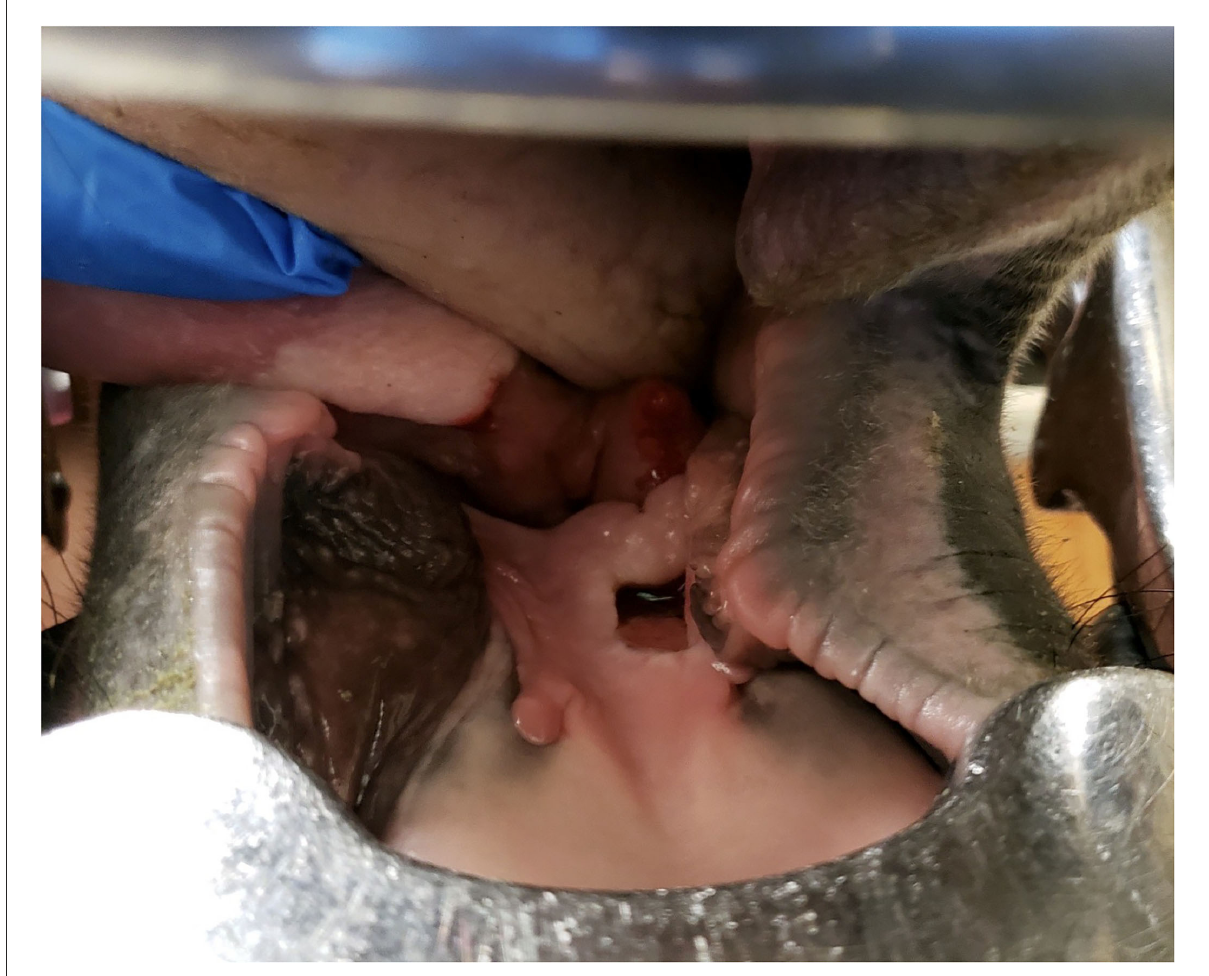
FIGURE3 Image of the intra-oral lesion on day 23 (treatment day 14) after initial